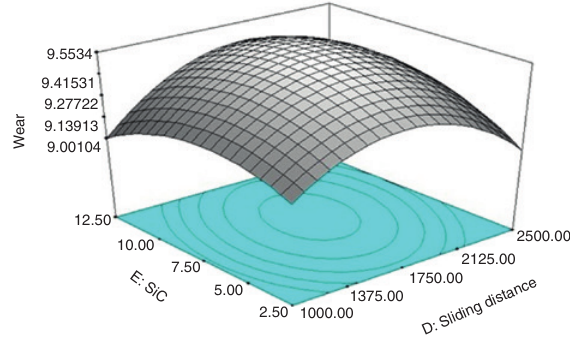
their F ratios, as shown in Table 4. It can be concluded that sliding velocity contributes most, followed by sliding distance, SiC wt.%, normal load, and carbonized eggshell wt.% in reducing the wear rate of the AA2014/6.5%